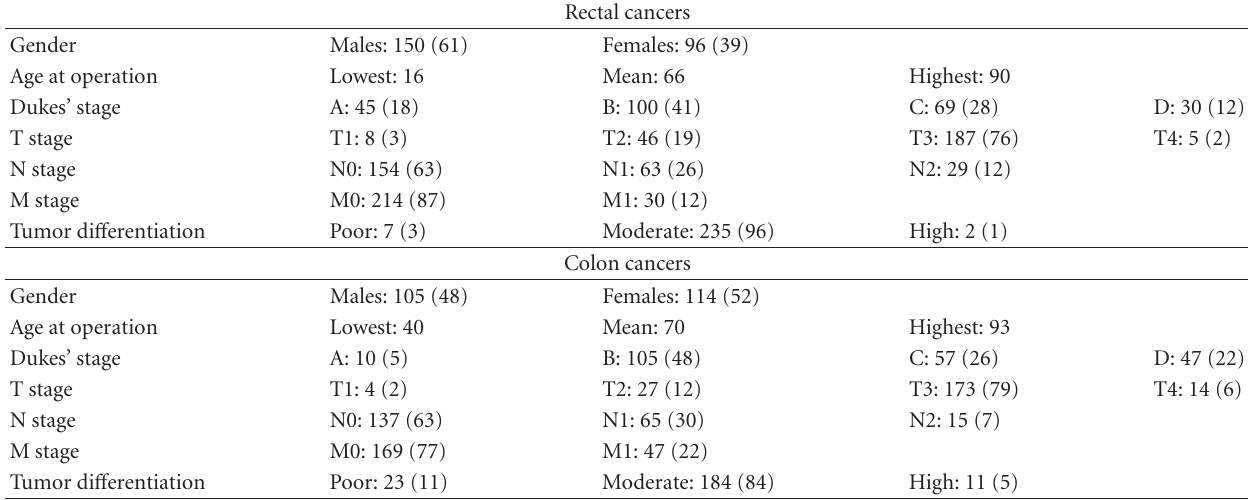
Table 3: Rectal and colon cancers’ characteristics, numbers (percentages in parentheses, (%)). Rectal cancers